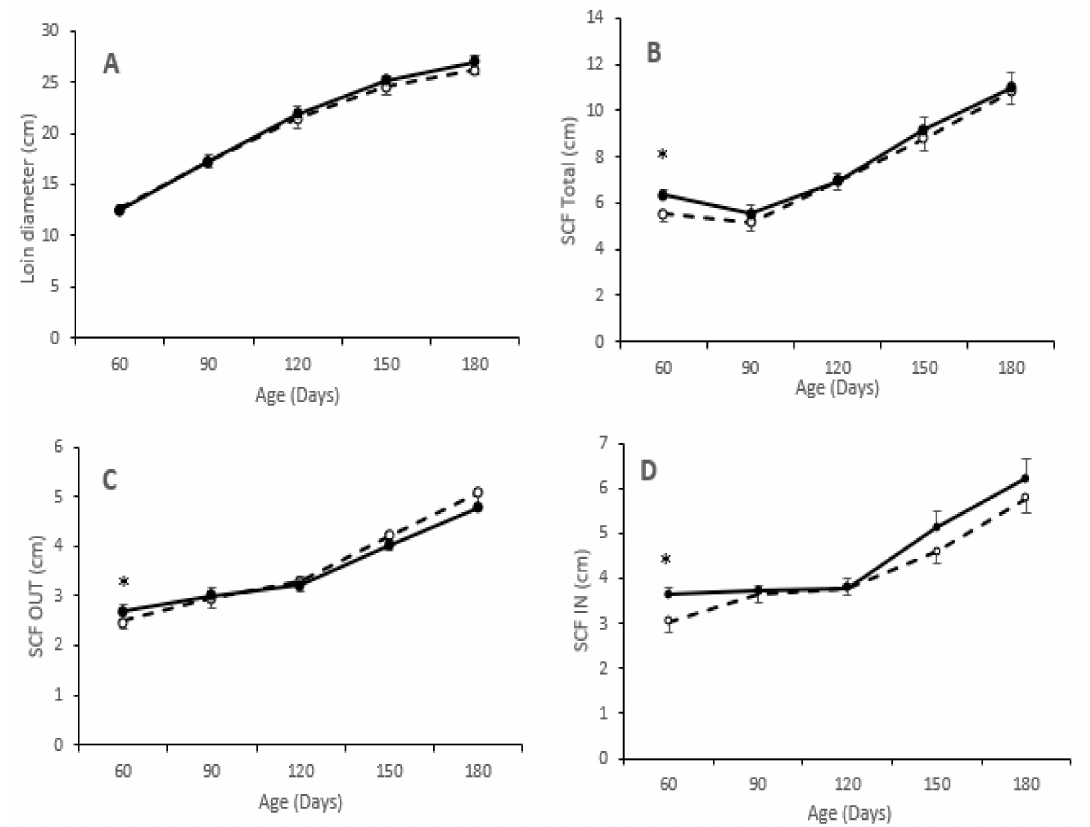
Figure 2. Changes over time in mean values ( ± S.E.M.) of loin diameter (panel ( A )) and depth of total subcutaneous back-fat (panel ( B )) and of its outer and inner layers (panels ( C , D ), respectively) during juvenile development (60 to 180 days-old) of pigs born from sows treated or not with hydroxytyrosol and linseed oil during pregnancy (groups T (black dots with continuous line) and C (white dots with discontinuous lines), respectively). Asterisks denote significant di ff erences between groups (* p < 0.05).